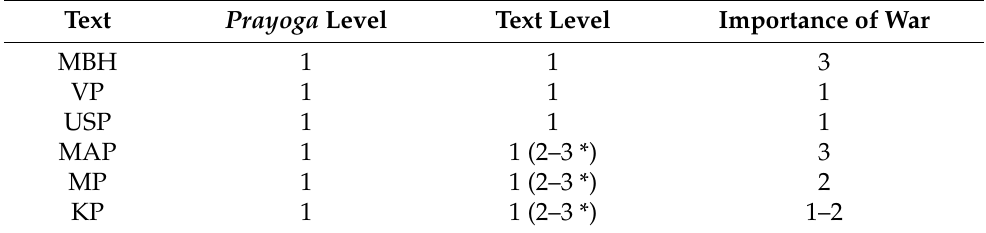
Table 2. The degree of transgression in war- prayogas in the epic and pur¯an. ic texts compared to the overall character of each text and the importance of war-related materials.